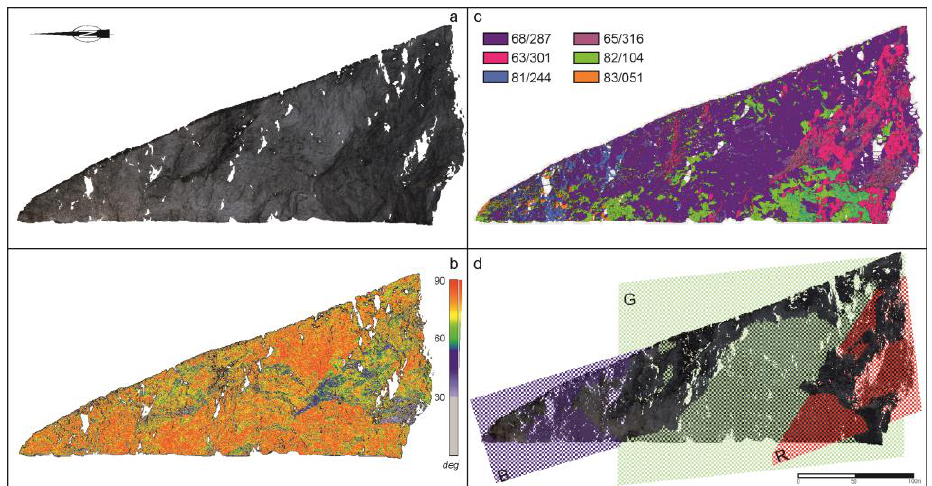
Figure 8. The geometrically corrected point cloud of the Porto Katsiki cliff, above the beach, in real color ( a ). The generated mesh file was classified according to each facet’s dip in degrees ( b ) and each one’s dip direction ( c ). The latter led to ( d ) a cliff segmentation into three generic morphological planes; Blue (81/244), Green (68/287) and Red (63/301).